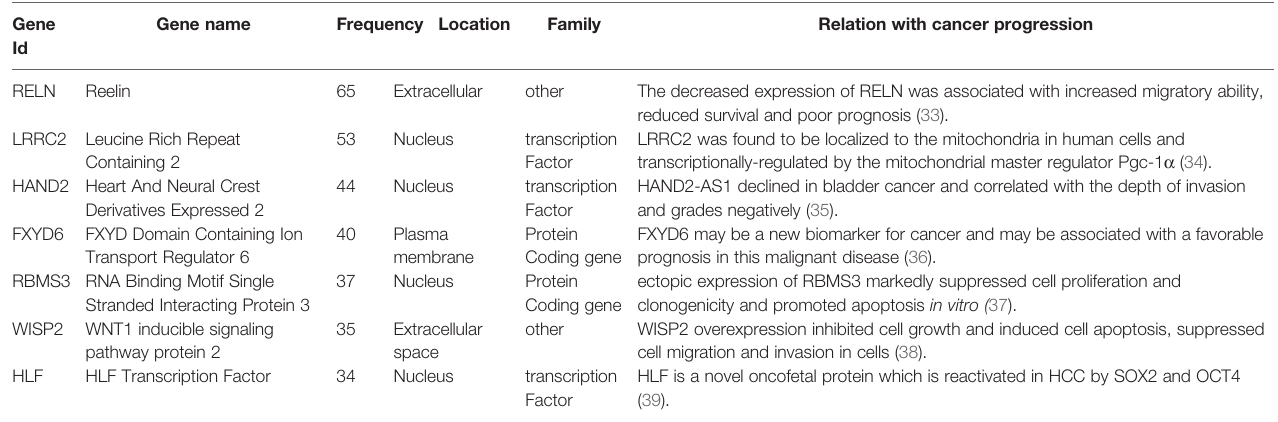
TABLE 3 | The high frequency genes in 130 “ sJSD signal biomarkers ” groups at the critical stage (stage II) for